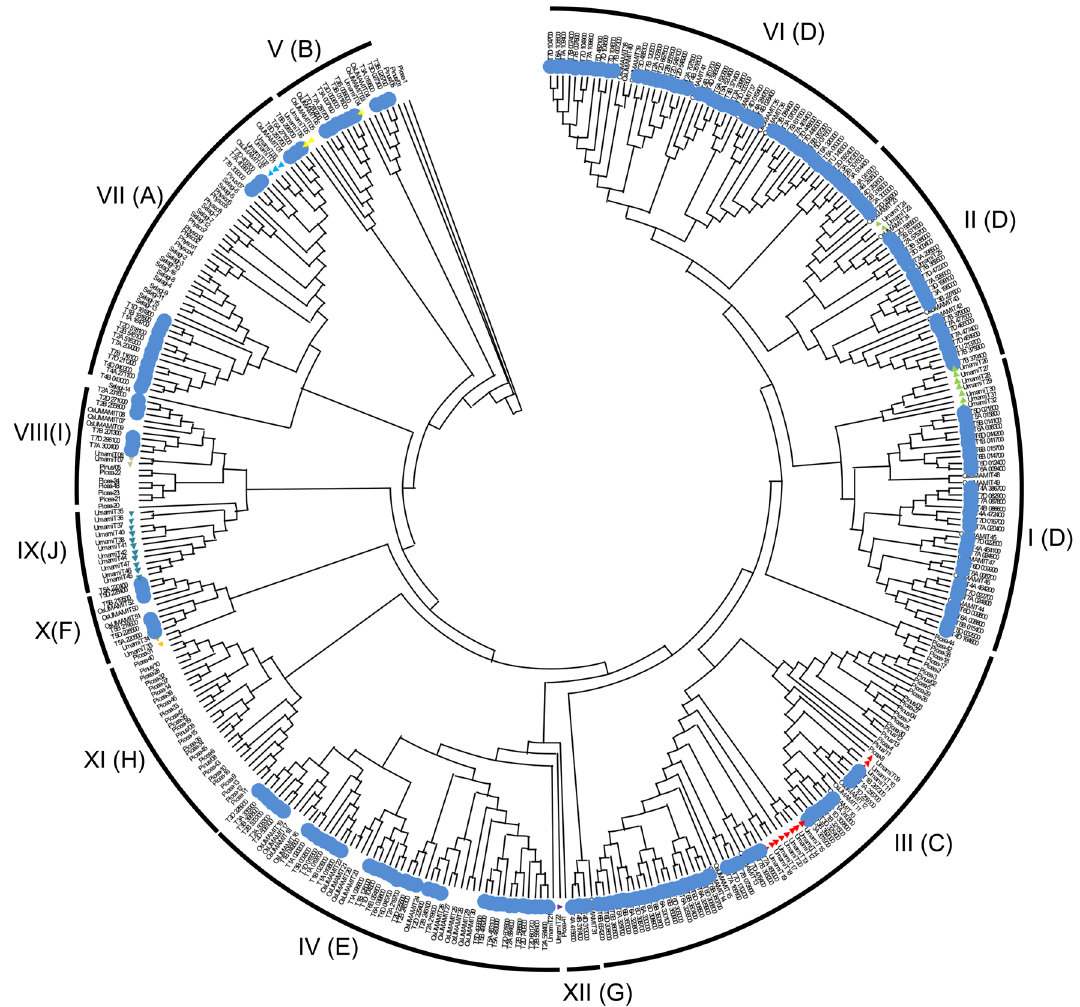
Figure 1. Phylogneitc relationship between UMAMITs of wheat and other species. The wheat gene IDs are abbreviated as; TraesCS1A02G019700 = Ta1A019700, indicated by blue dots. UMAMITs from other species are indicated as follows: Arabidopsis thaliana, no abbreviations (UMAMIT); Physco, Physcomitrella patens ; Selagi, Selaginella moellendorffii ; Pinus, Pinus pinaster ; Picea, Picea abies ; Os, Oryza sativa . Arabidopsis UMAMITs are indicated with triangles. The clade IDs have been assigned according to the numbers based previous publications 13,24 . The corresponding clade in Zhao et al. is indicated in parenthesis 25